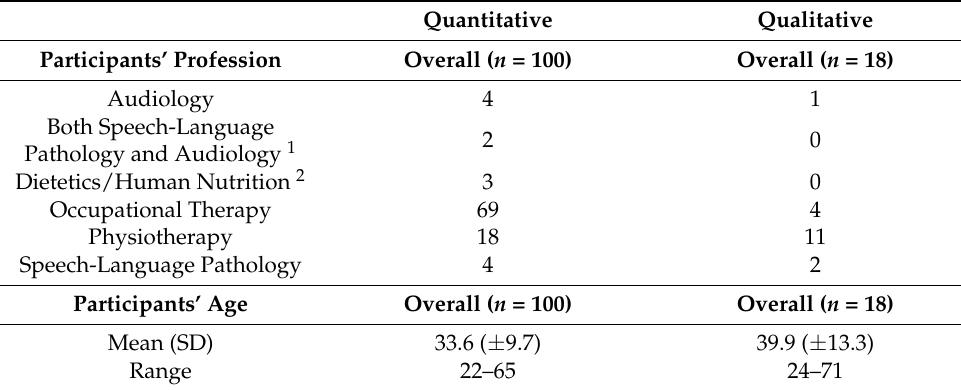
Table 1. Demographic information.